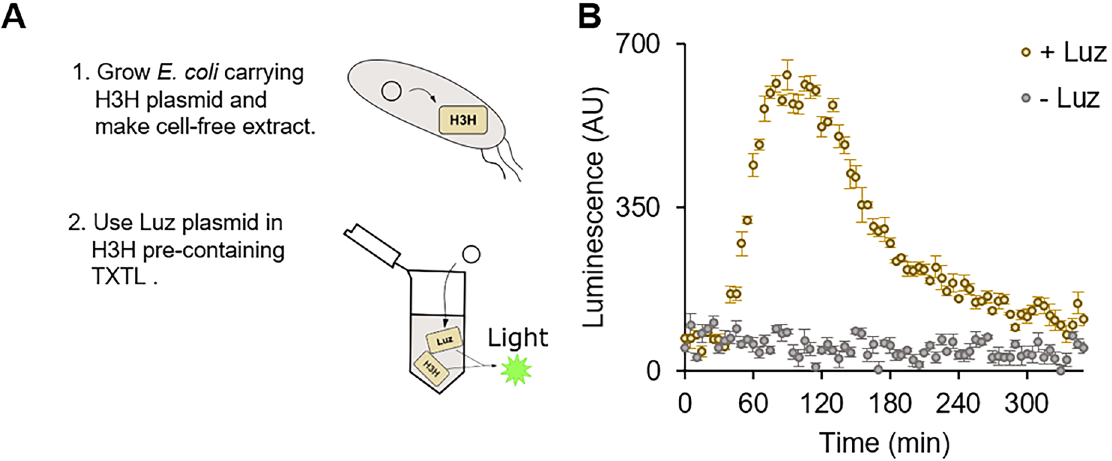
Figure 4. H3H-Luz tested with metabolic burden-reduced TXTL. ( A ) The schematic of how H3H-carrying TXTL works. The plasmid coding H3H gene under the sigma 70 promoter is transformed into E. coli Rosseta 2 strain. The cell-free extract is made with that strain; thus, the extract contains H3H. Once Luz is expressed in the TXTL, Luz produces luminescence by coordinating with H3H. ( B ) Luminescence measurement in the H3H pre-containing TXTL. Luz plasmids were incubated with hispidin at 30 °C in TXTL. The Luz plasmid containing reaction (yellow dots) generated light during the TXTL reaction, while the reaction without Luz plasmid did not (black dots.) The graphs show means with error bars that signify SEM (n = 3).